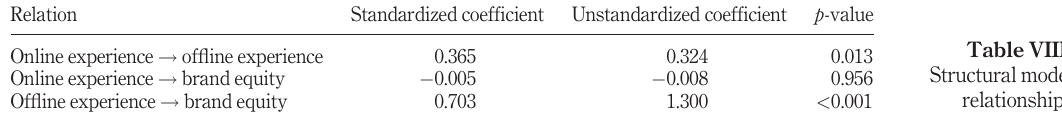
Table VII. Relationship between dimensions and their construct